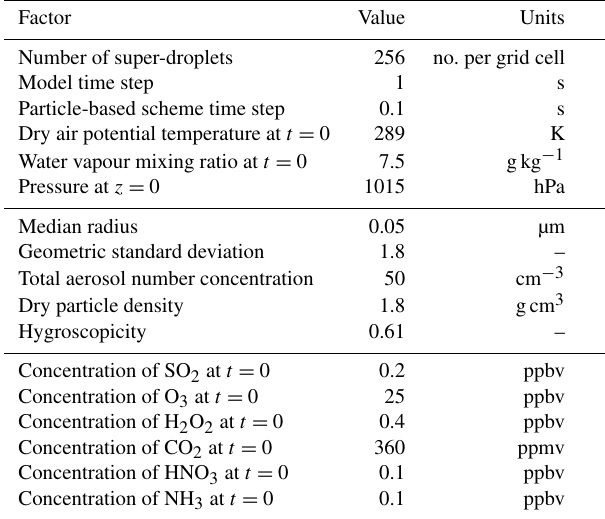
Table 2. Initial conditions for the base case of the 2-dimensional kinematic model.